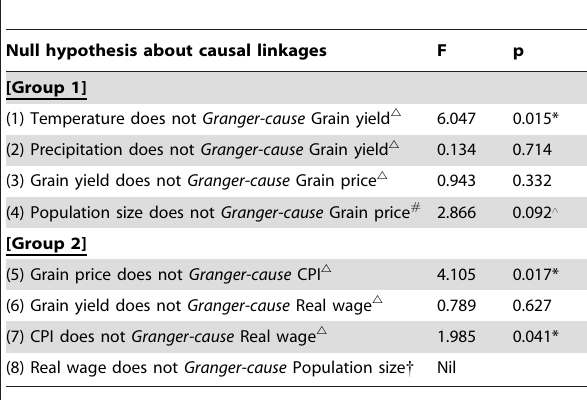
Table 2. GCA Results for Each of the Causal Linkages by Raw